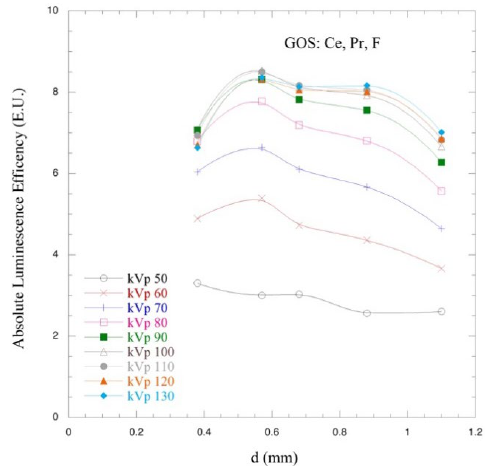
Figure 8. The ALE as a function of thickness for GOS:Pr,Ce,F for different X-ray tube voltages. The solid lines in the graphs are guides for the eyes. solid lines in the graphs are guides for the